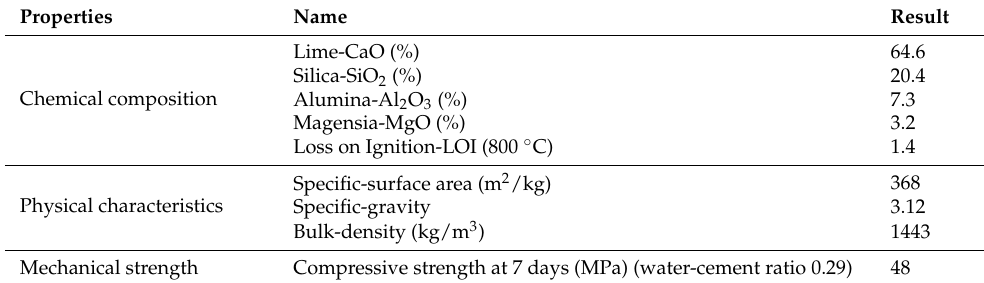
Table 1. Properties of